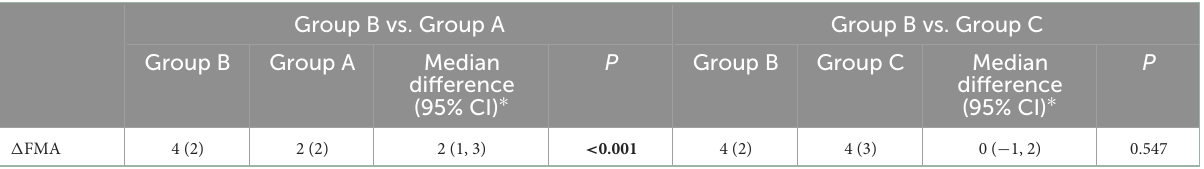
TABLE 4 Comparison of 1 FMA between the soft machine glove group and the conventional therapy and repetitive transcranial magnetic stimulation groups. Group B vs. Group A